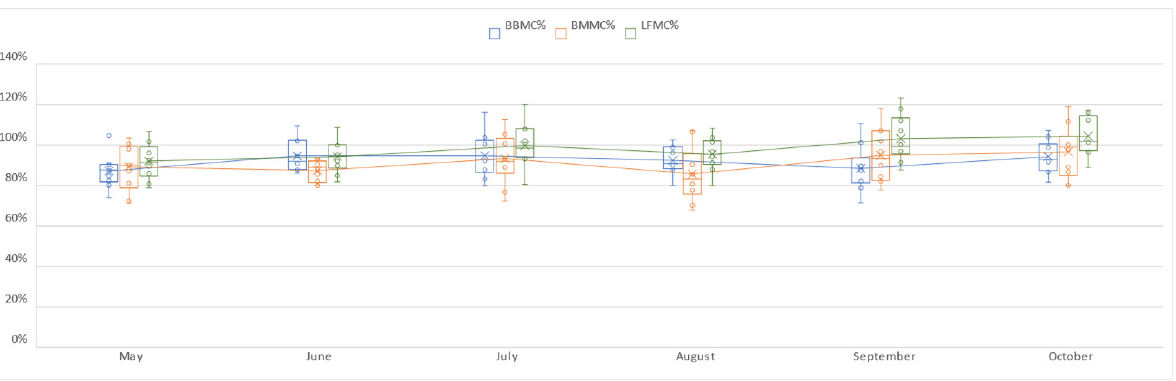
Figure 3. Comparison between moisture content in different branch fractions of Pinus halepensis from May to October 2021: branch base (BBMC%, middle of the branch (BMMC%) and fine live fuel (LFMC%).